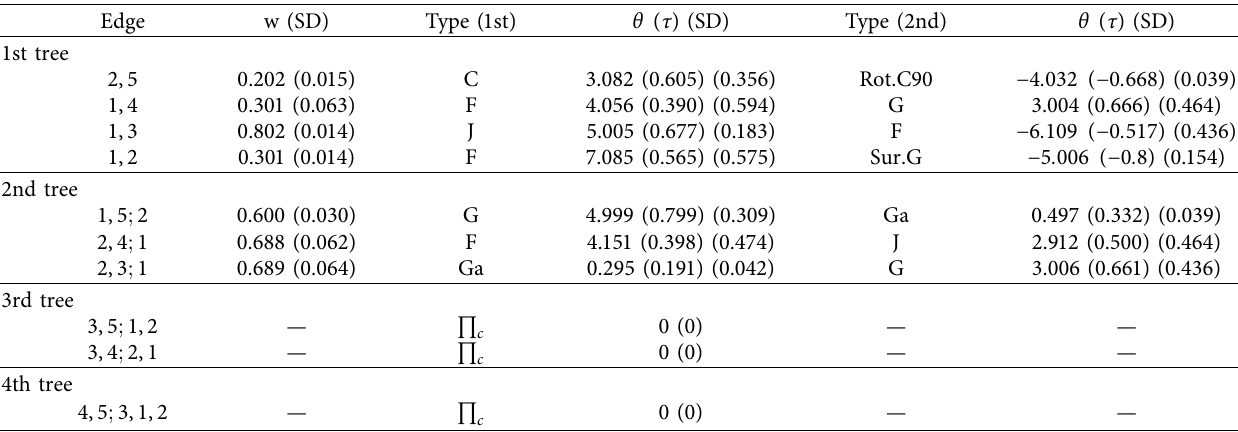
Table 6: Summary of 2-levels truncated R -vine copula mixture